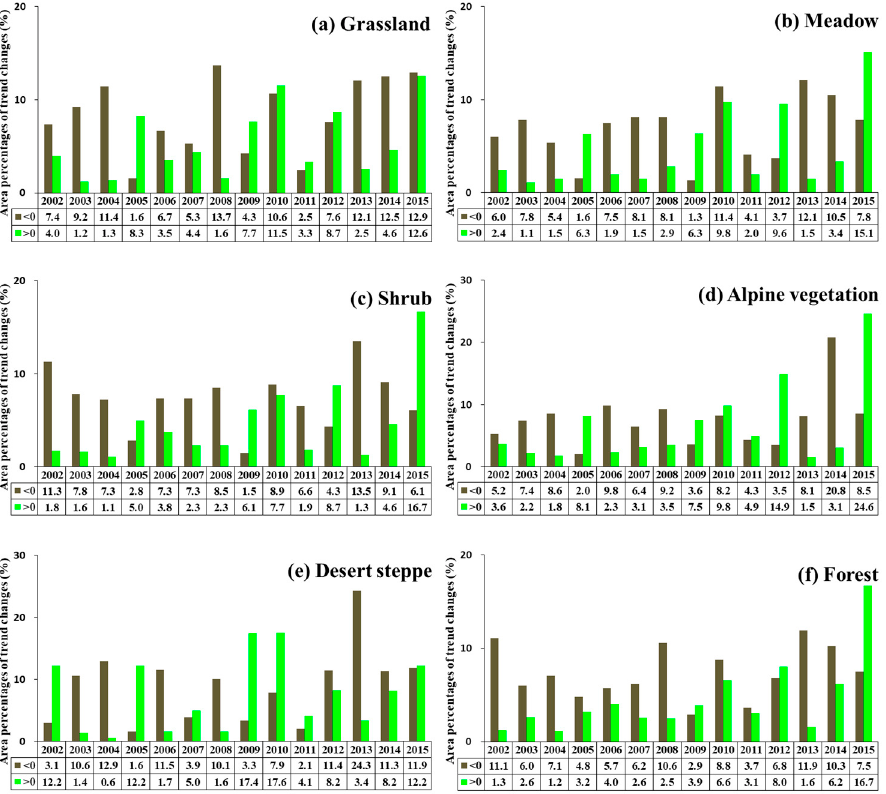
Figure 7. Area percentages of negative and positive trend changes for each year of the study period (2000–2017). Negative and positive values indicate abrupt vegetation browning and abrupt vegetation greening,